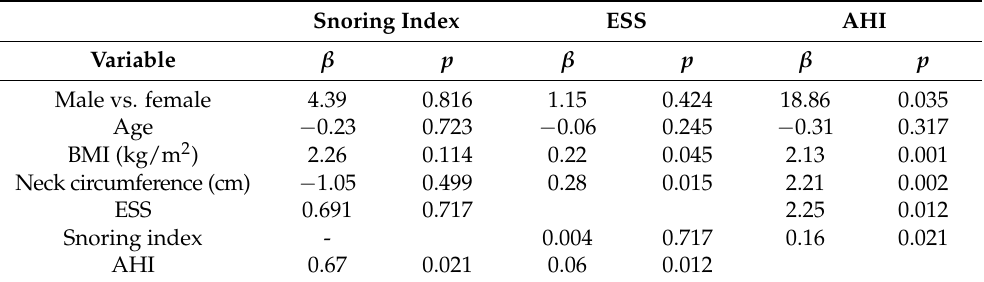
Table 3. Univariate linear regression for the snoring index, Epworth sleepiness scale, and apnea– hypopnea index. Snoring Index